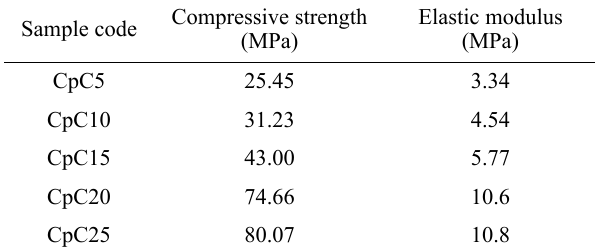
Table 5 Mechanical response of composite samples under compression test.